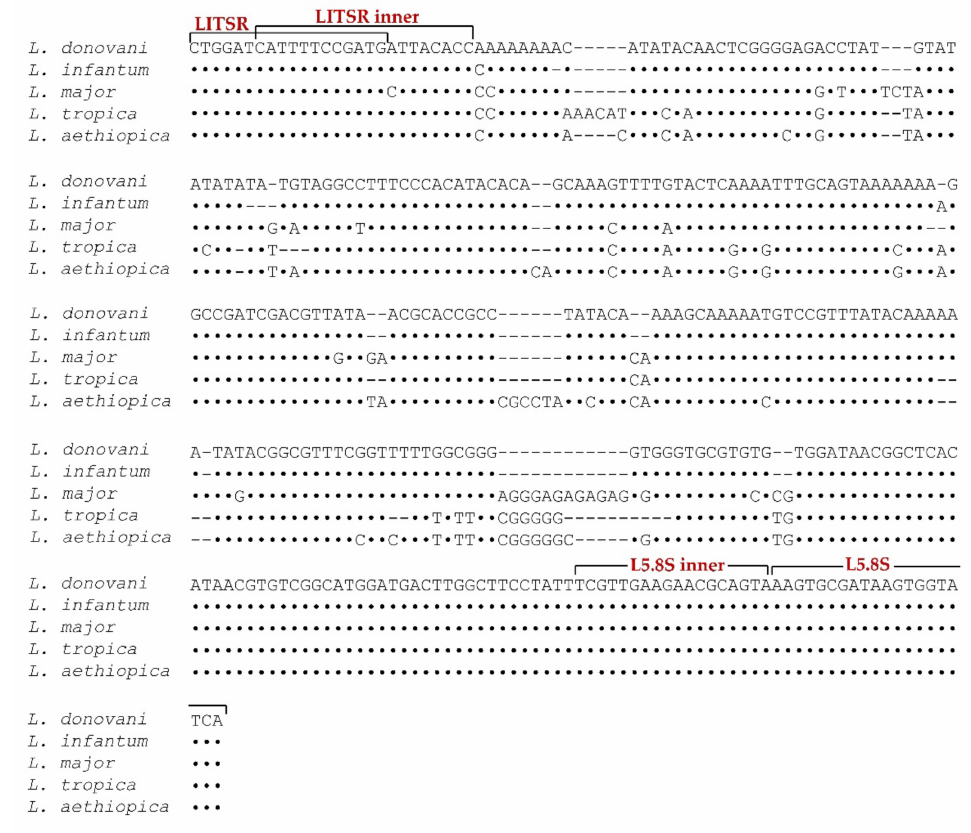
Figure 1. Alignment of Internal Transcribed Spacer 1 and 5.8S ribosomal RNA gene fragments of different Leishmania species. The dots denote identical sequences with those of Leishmania donovani and the dashes indicate gaps introduced for maximal alignment. The positions of the primers used in this study are